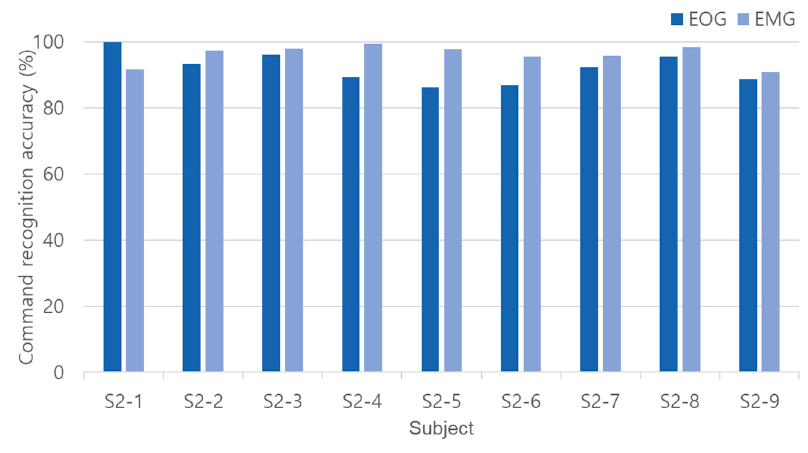
Figure 14. Command recognition accuracy in virtual keyboard interface test. Table 1. EOG and sEMG signal based command accuracy results in virtual keyboard interface test.